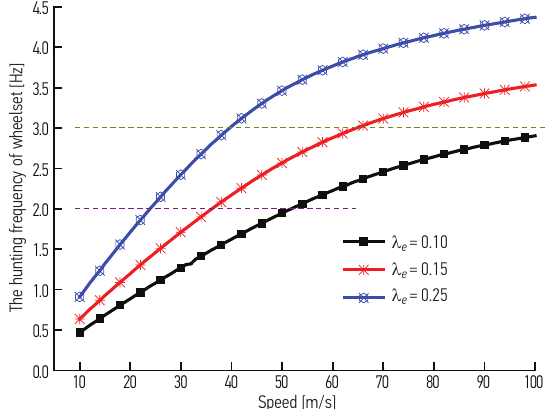
Fig. 11. The vibration amplitude ratio of the bogie frame and wheel-set with different f y